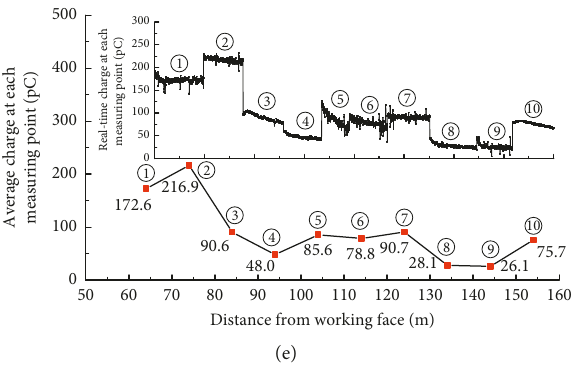
Figure 10: Monitoring results of charge at each monitoring point. (a) Day 1. (b) Day 2. (c) Day 3. (d) Day 4. (e) Day